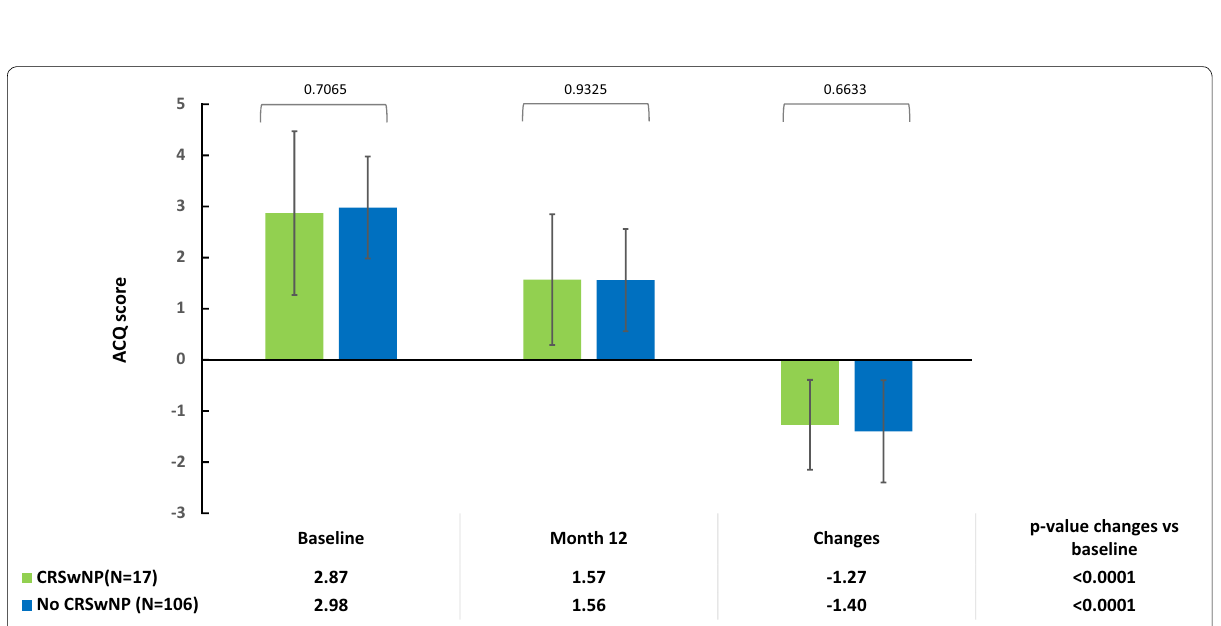
SD unless otherwise stated ±